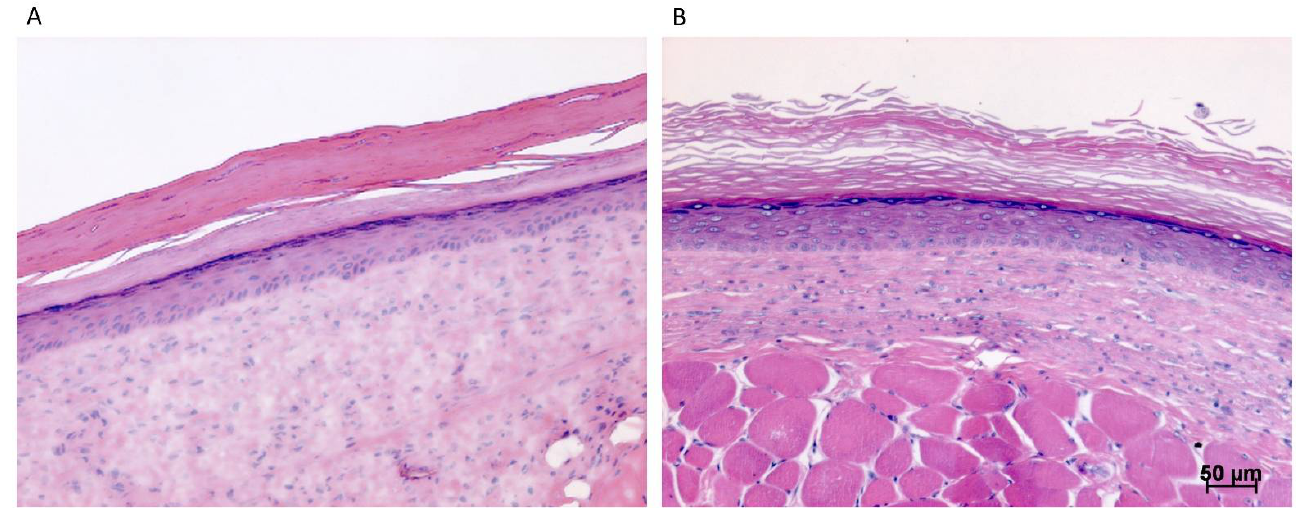
Figure 4. Hematoxylin and eosin staining of SASSs harvested 21 days after grafting on the back of athymic mice. ( A ) Skin substitute grafted without IMS and bolster. ( B ) Skin substitute grafted with IMS and bolster.